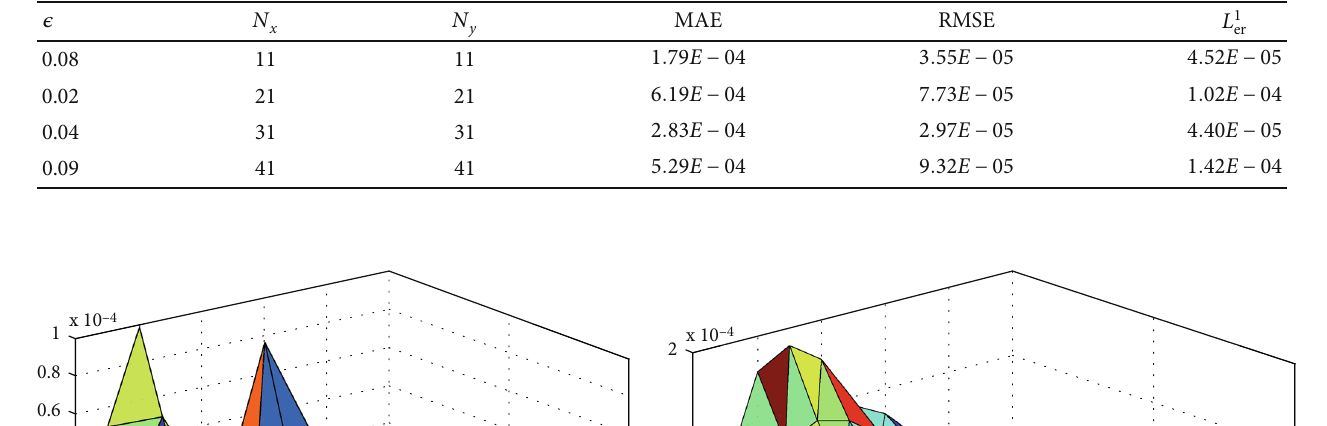
, N , and ϵ using IMQ. x y